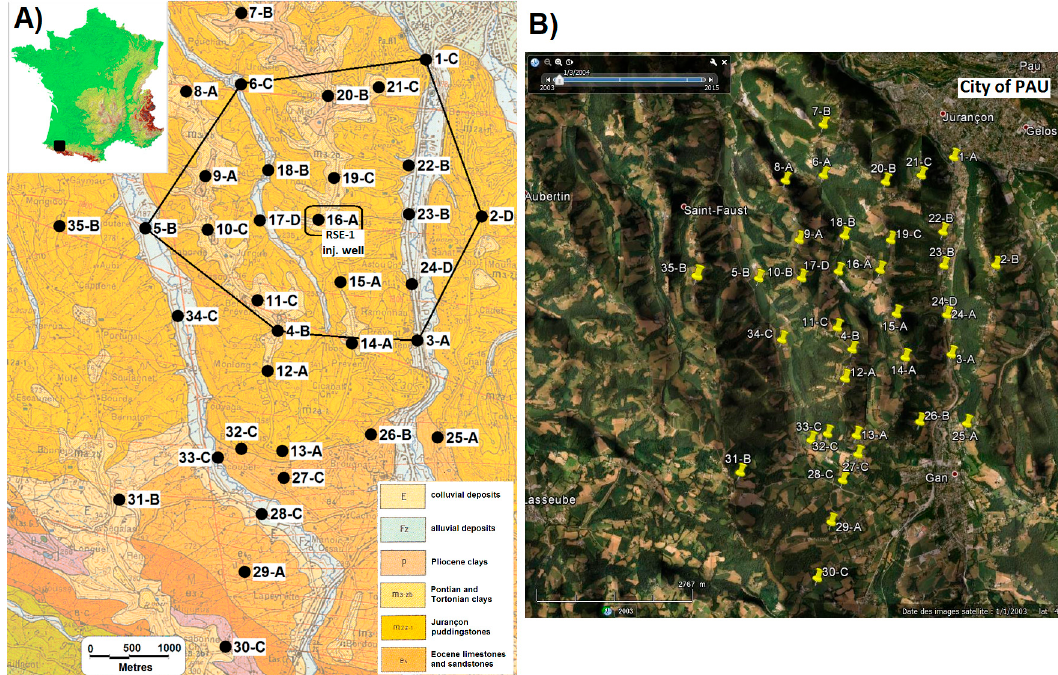
Figure 1. ( A ) Locations of the 36 monitoring points (35 different locations) plotted onto a geological map. The hexagon shape links the six geophysical observation boreholes for passive seismic monitoring down to 2 km-depth. Point 16-A is close to the location of the injection well (RSE-1). ( B ) Monitoring points plotted on Google Earth satellite view using shaded relief (afternoon view).